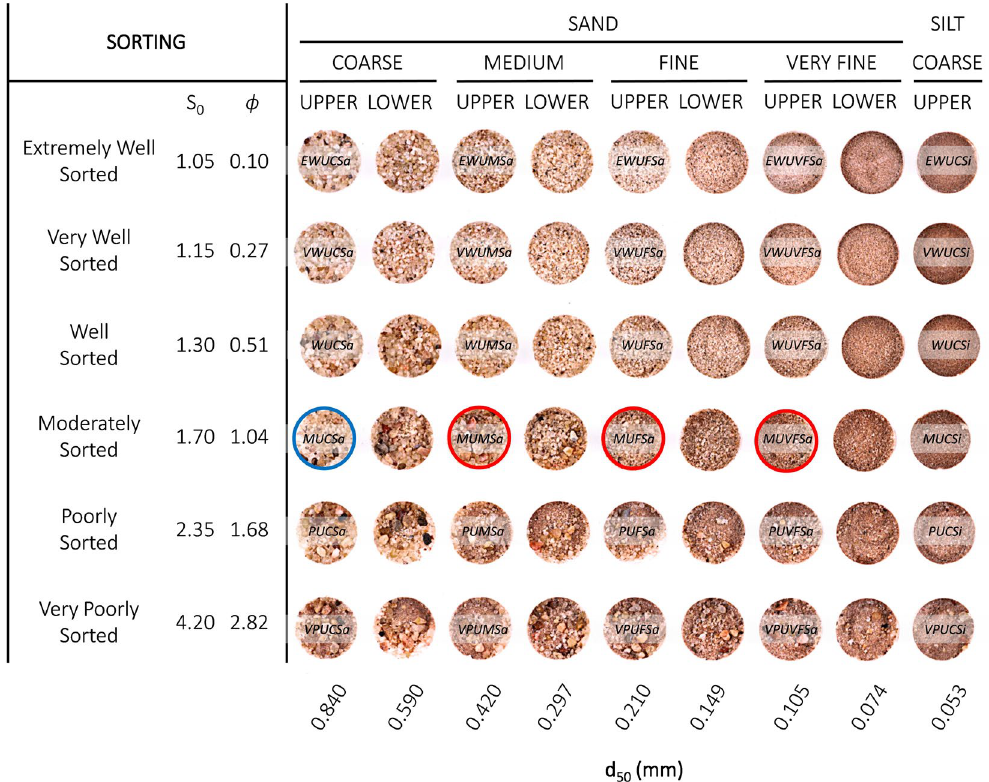
Figure 2. The 54 textural classes used for assignment of matrix and laminae in the models. Each facies has a specific distribution of grain sizes described by a median value (columns) and sorting category (rows). Sorting is given in terms of Trask coefficient S o and φ scale 30 . These facies are characteristic of a wide range of depositional processes and environments. For example, very-fine grained, well-sorted silt is typical of upper point bar fluvial deposits; poorly sorted coarse sand is more typical of channel thalwegs. Very well sorted medium sand is typical of shoreface environments. Median grain diameters at the bottom are in millimeters. Permeabilities for these materials range from 471 Darcy (extremely well sorted upper coarse sand, upper left) to 50 milli-Darcy (very poorly sorted upper coarse silt, lower right) (Beard and Weyl 29 , their Table 6). To illustrate the methodology used for generating different textural contrasts, three cases are shown where MUCSa represents the matrix facies and MUMSa, MUFSa, and MUVFSa are used for the laminae (see Fig.